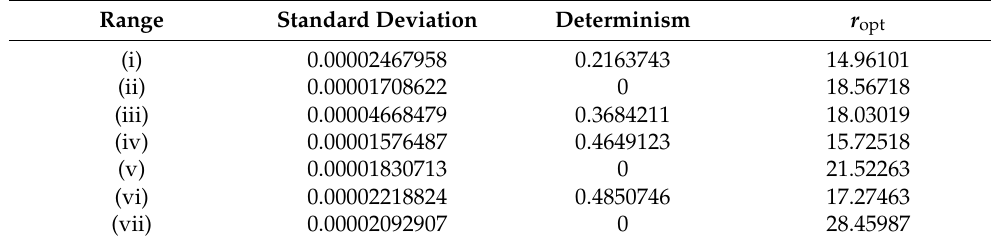
Table 1. Characterization of the log returns of copper for different time